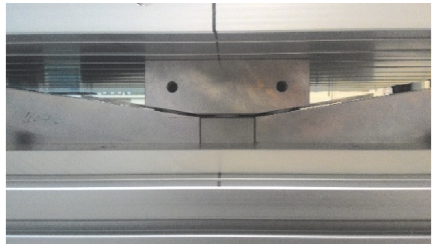
Figure 1: The proposed Bi-Tilt